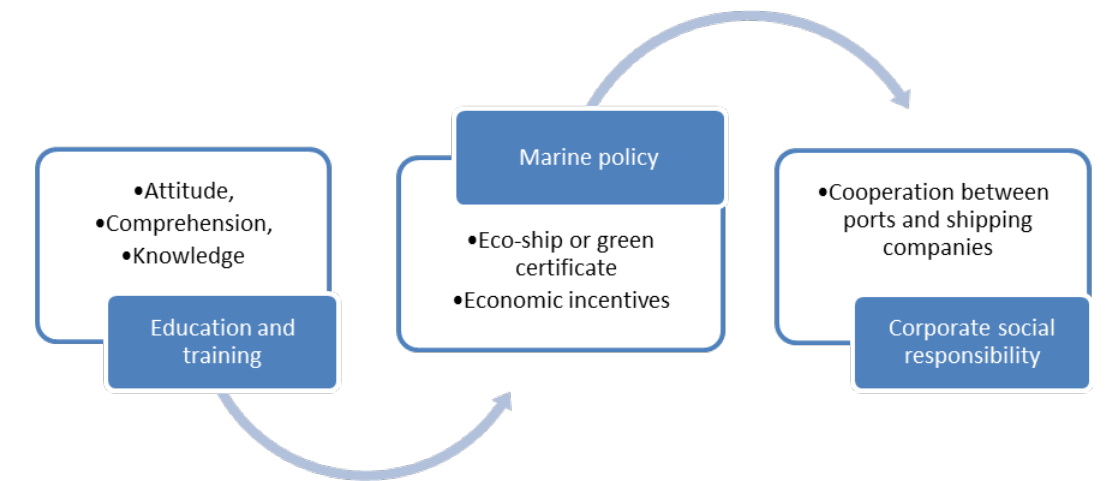
Figure 6. Proposals for the improvement of the ecological competence of society in the maritime and port sectors.